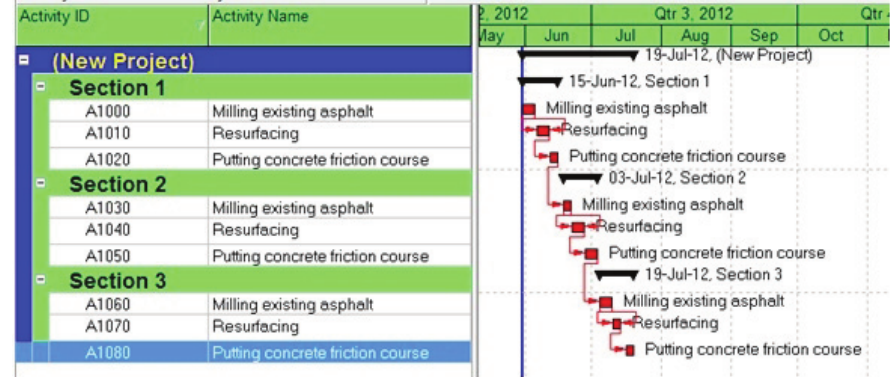
Fig. 6. Example schedule for a resurfacing